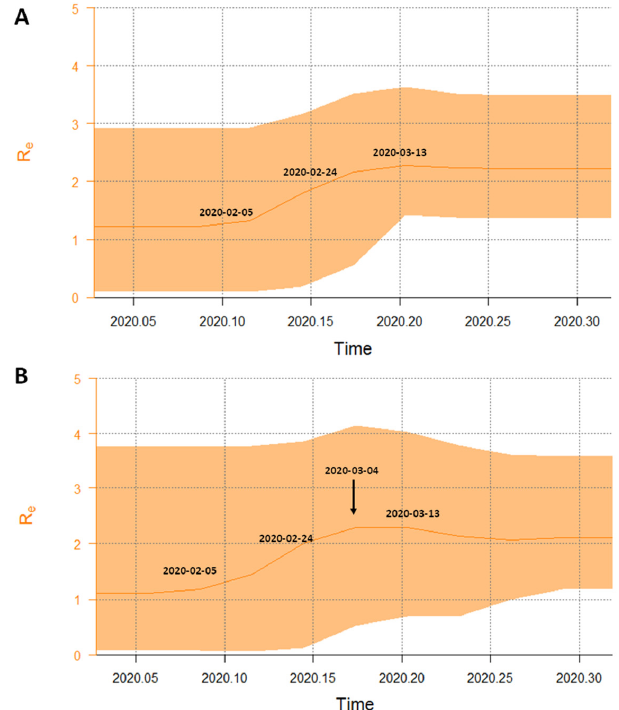
Figure 4. Part A : birth-death skyline plot of the SARS-CoV-2 outbreak allowing one R e intervals. Part B : birth-death skyline plot of the SARS-CoV-2 outbreak allowing three R e intervals. The curves and the orange areas show the mean R e values and their 95% confidence intervals. The Y and X axes indicate R values and time in years, respectively.